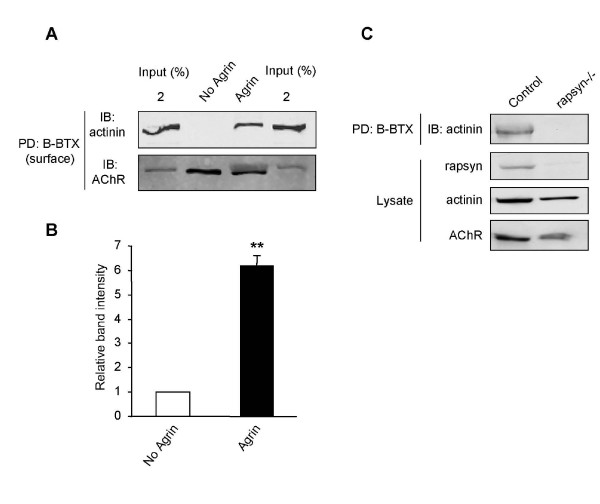
A ternary complex of AChR, rapsyn, and α-actinin. (A) Live C2C12 myotubes were incubated with B-BTX for 2 hr at 4°C. Surface receptors were purified by streptavidin-coupled agarose beads. AChR-associated proteins were probed with antibodies specific for α-actinin and the AChR β-subunit. (B) Quantitation of blot. The amount of α-actinin associated with surface AChRs was increased upon in agrin-stimulated myotubes. Data represent mean ± SEM of three experiments. **, p < 0.01, two-tailed Student's paired t test. (C) α-Actinin was not associated with AChRs in rapsyn -/- myotubes. Control and rapsyn mutant myotubes were treated with agrin. AChRs were labeled by B-BTX and probed for α-actinin.